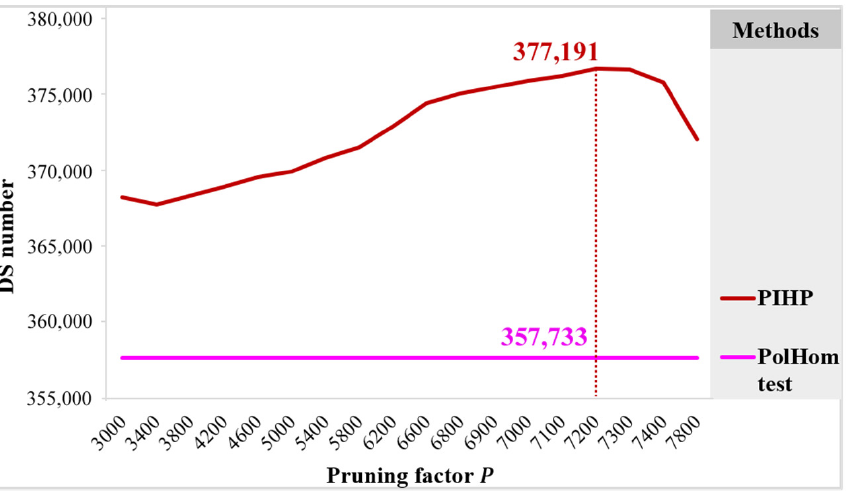
Figure 11. The DS numbers under different pruning factors P by the PolHom test and the PIHP method when β = 9.